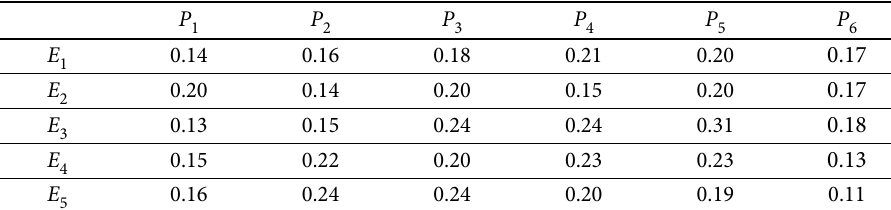
Table 5. Aggregated distances with OWAD operator